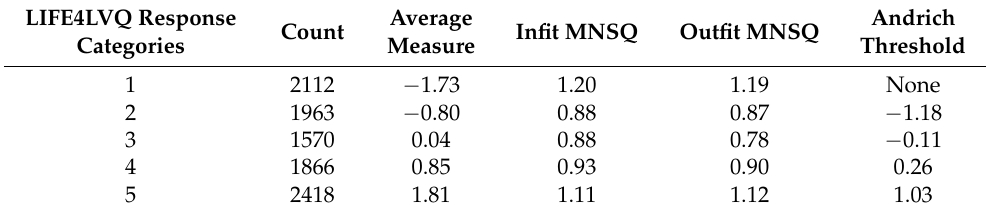
Figure 1. Category probability curves (CPCs) for the LIFE4LVQ. Each curve illustrates one response category (no difficulty/never = 1, little difficulty/little = 2, some difficulty/sometimes = 3, great difficulty/often = 4, and unable to do because of my vision/always = 5). The point where two adjacent curves overlap is the threshold. Thresholds in this case are adequately ordered. Table 4. LIFE4LVQ categories and Andrich